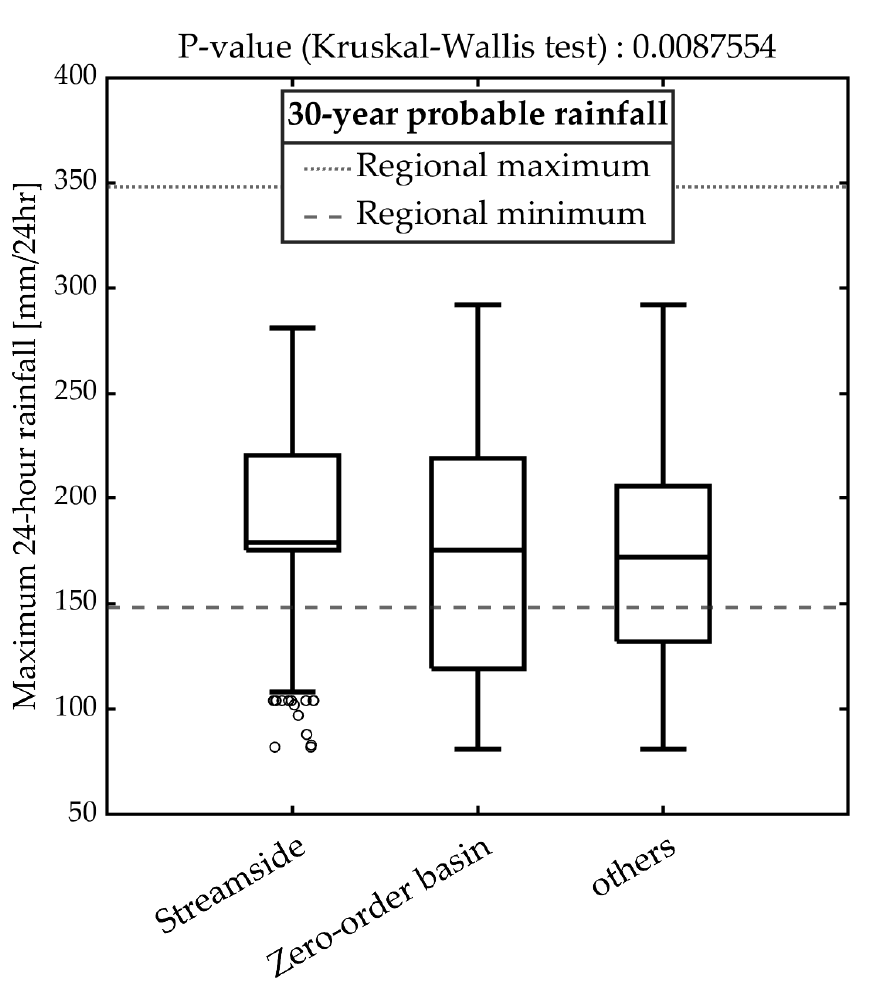
Figure 12. Distribution of maximum 24 h rainfall in the damaged area. The line in each box represents the median of the sample; the upper and lower ends of each box represent the upper and lower quartiles, respectively.